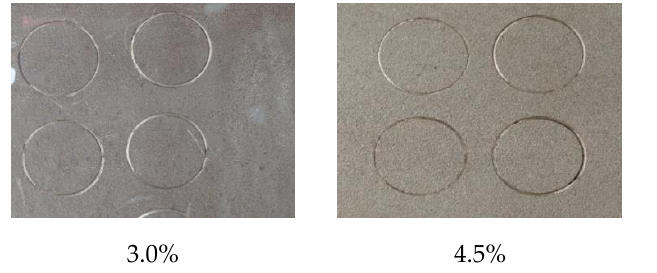
Figure 9. Rust on the surface of steel plate (comparison group).